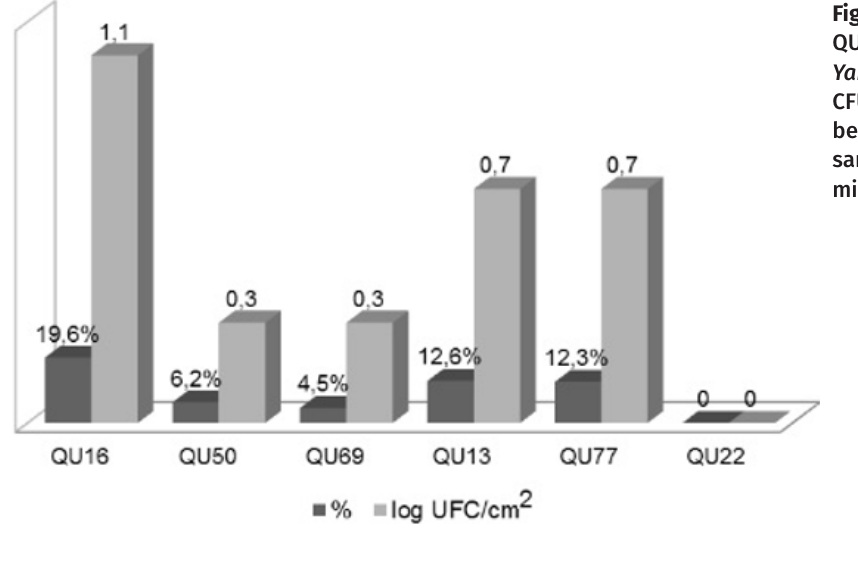
Figure 4. Survival of QU16, QU50, QU69, QU13, QU77, QU22 Yarrowia lipolytica isolates (log CFU/cm 2 ) on the beaker coupon before and after application of sanitizing product (DN3 %) % mild detergent 03-05 minutes.